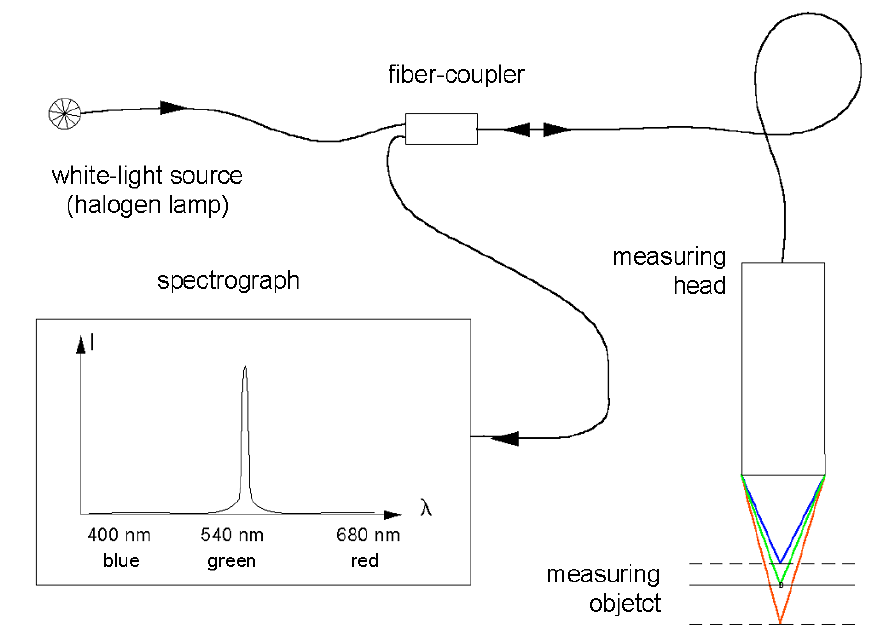
Figure 2. Schematic presentation of the measuring principle of chromatic confocal